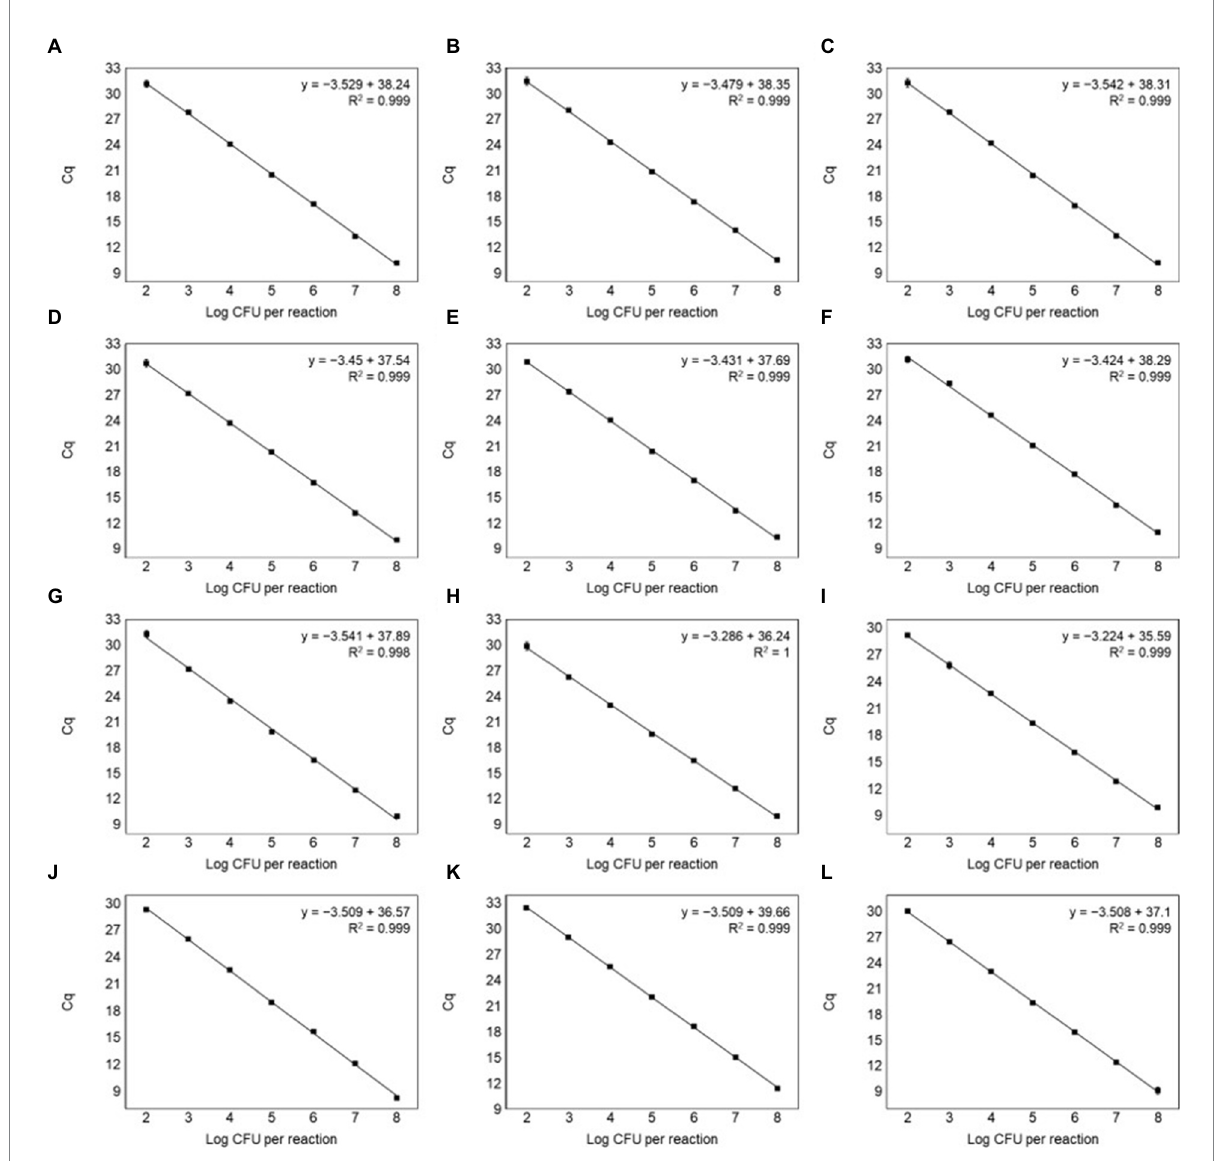
FIGURE 4 Standard curves by plotting Ct values against the log CFU/ml for (A) Leu . carnosum , (B) Leu . citreum , (C) Leu . fallax , (D) Leu . gasicomitatum , (E) Leu . gelidum , (F) Leu . holzapfelii , (G) Leu . inhae , (H) Leu . kimchii , (I) Leu . lactis , (J) Leu . mesenteroides , (K) Leu . pseudomesenteroides , and (L) Leu . suionicum in inhae pure culture. All samples were tested in